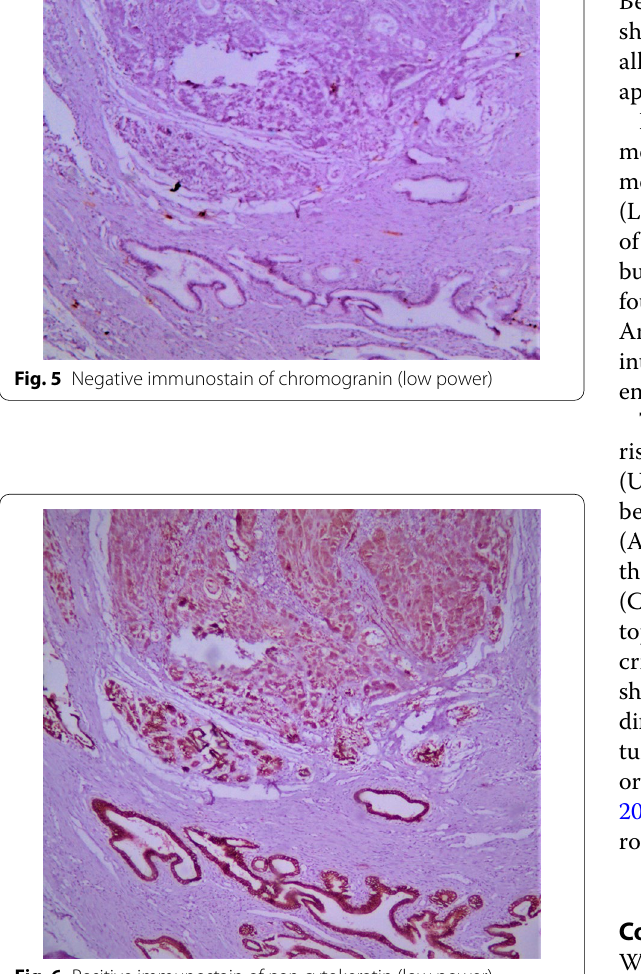
Fig. 6 Positive immunostain of pan cytokeratin (low